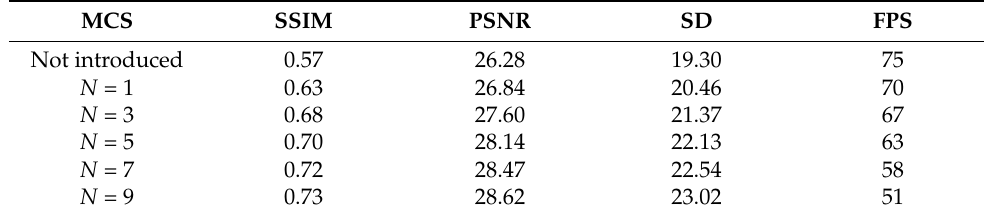
Table 6. Introducing the Monte Carlo search time comparison.